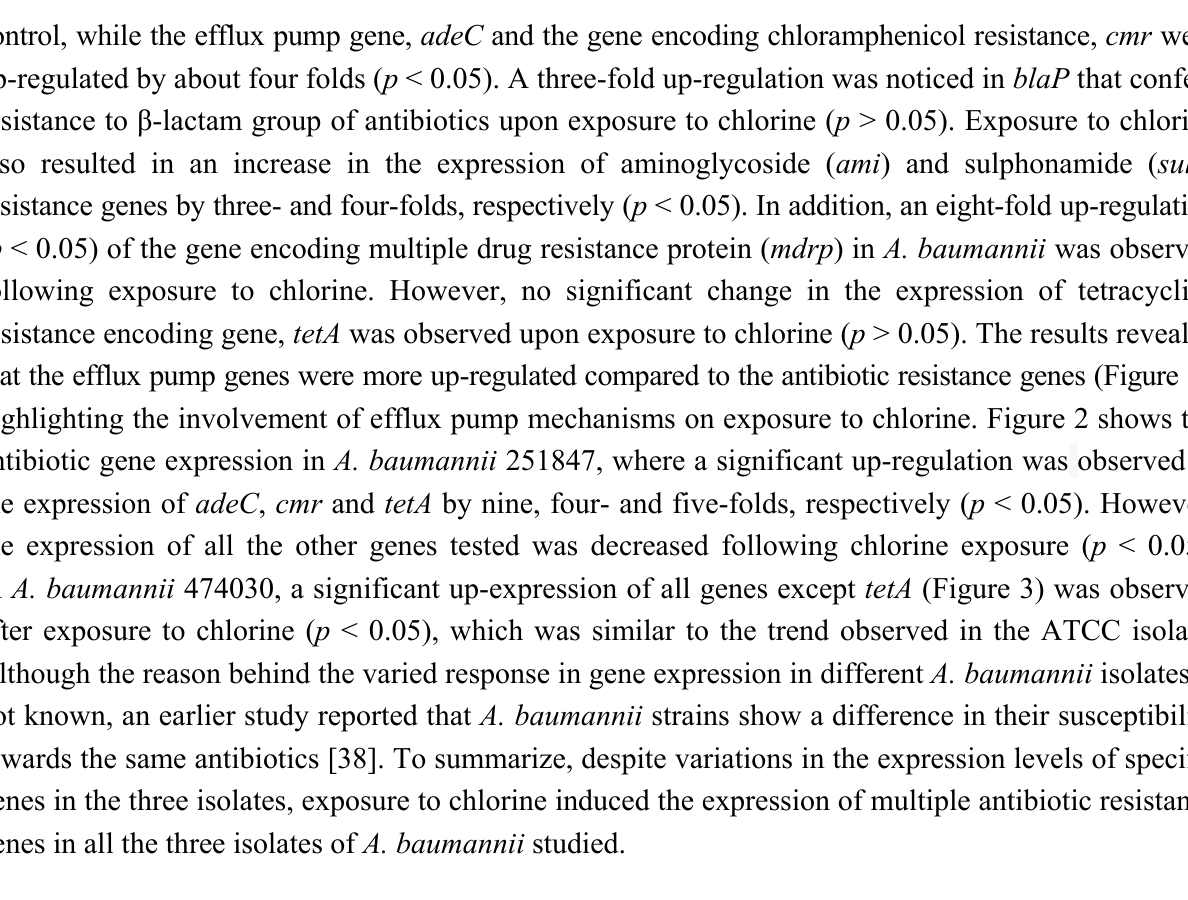
Figure 2. Effect of chlorine exposure on antibiotic resistance gene expression in A. baumannii